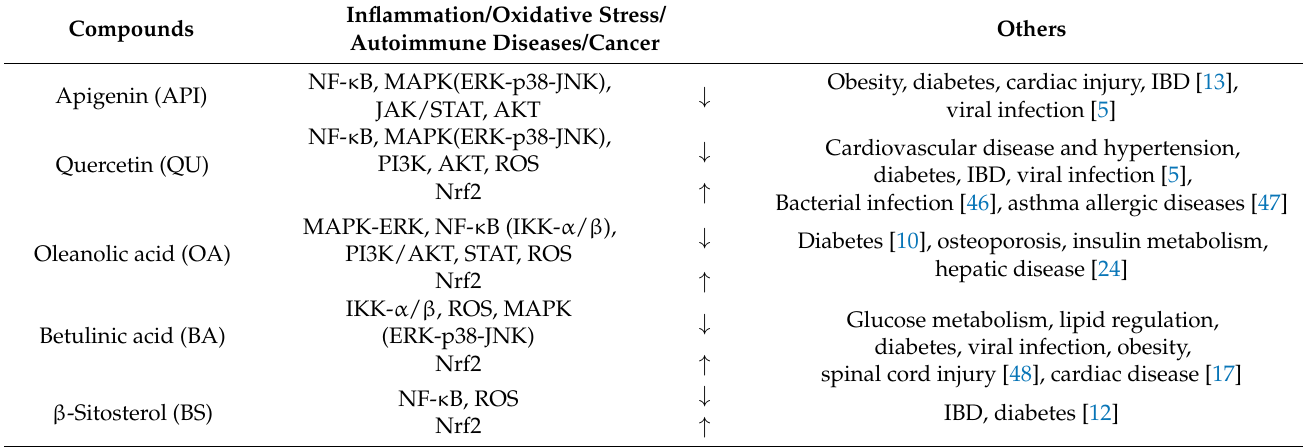
Table 2. Immune responses of natural bioactive